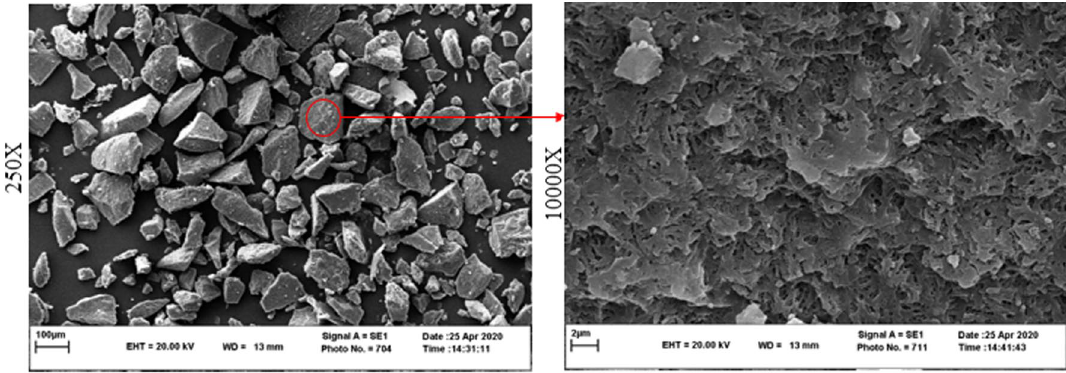
Fig. 3 SEM image of the raw S. platensis